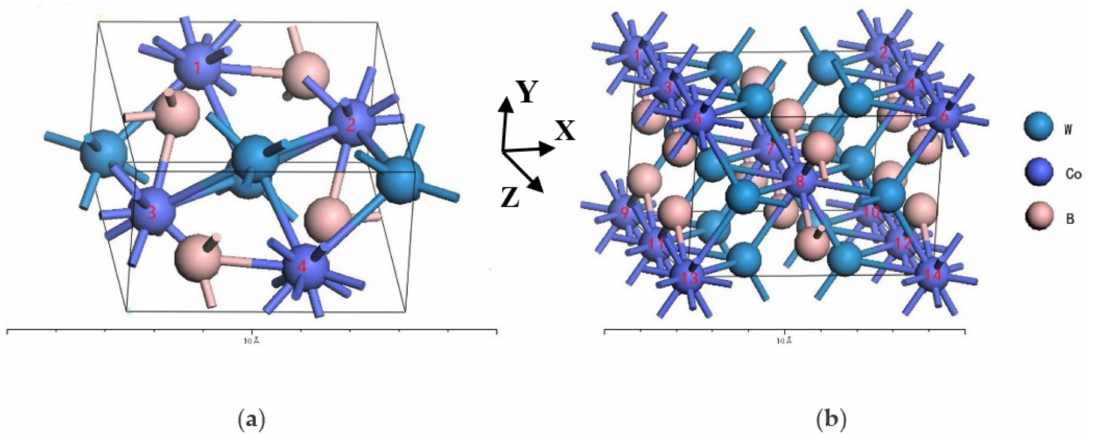
Figure 1. Orthorhombic structure of V doping ( a ) WCoB (W 4 Co 4 − x V x B 4 , x = 0, 1, 2, 3, 4) and ( b ) W 2 CoB 2 (W 8 Co 4 − x V x B 4 , x = 0, 1, 2, 3,